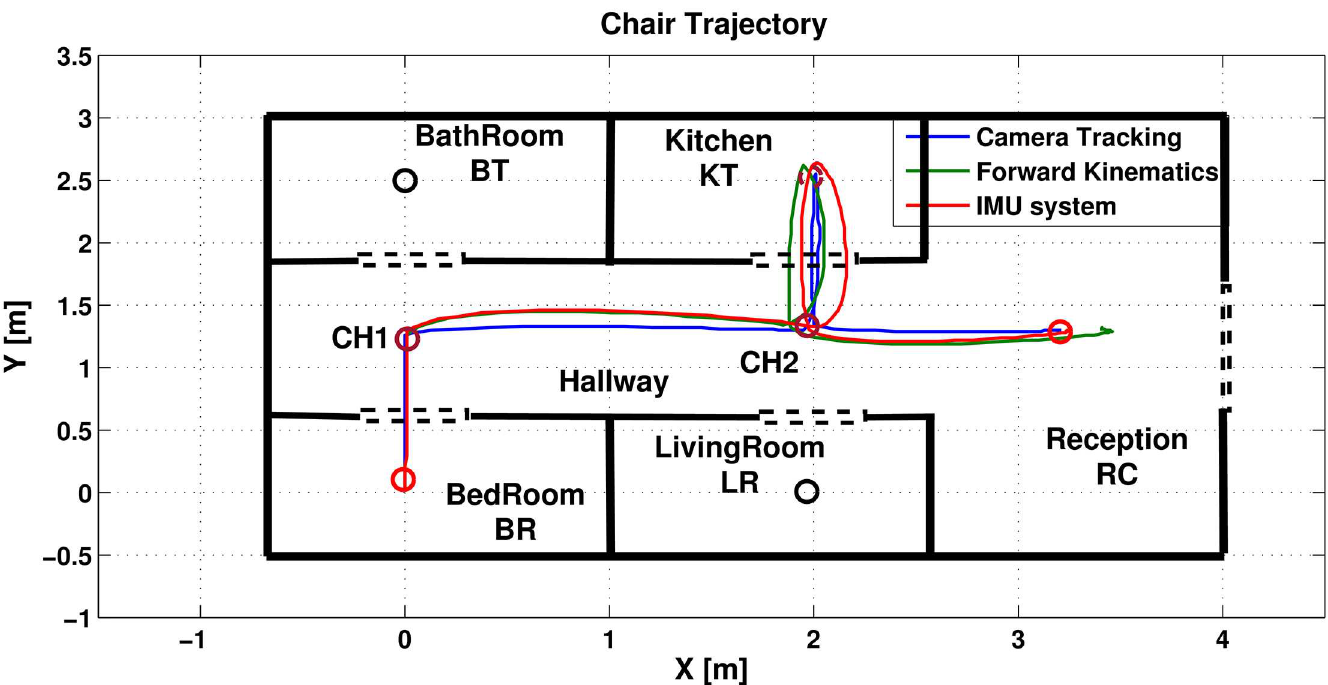
Fig 5. Wheel hair trajectories for FR, IMU and camerapositioning